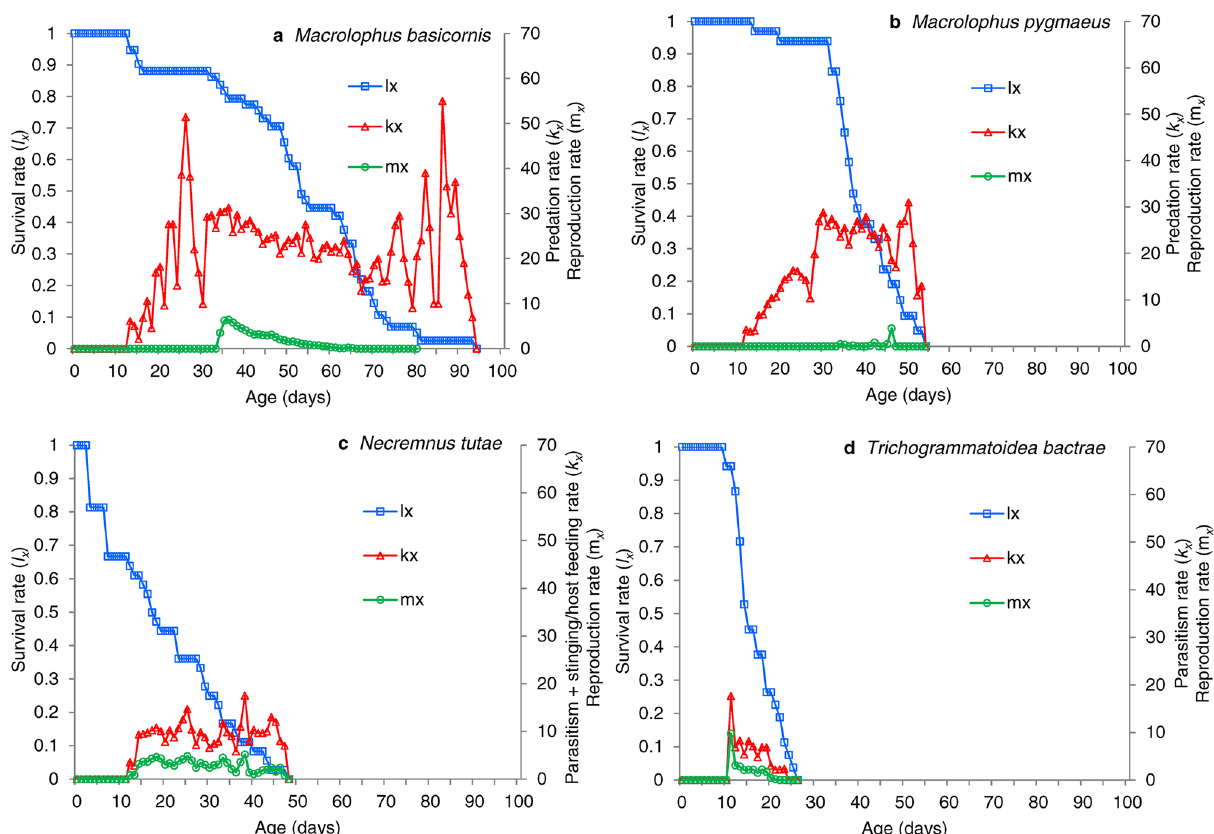
Figure 4. Examples of survival rate ( l x ), the reproduction rate ( m x ) and predation/parasitism rate ( k x ) values over the lifetime of selected species of predators and parasitoids of Tuta